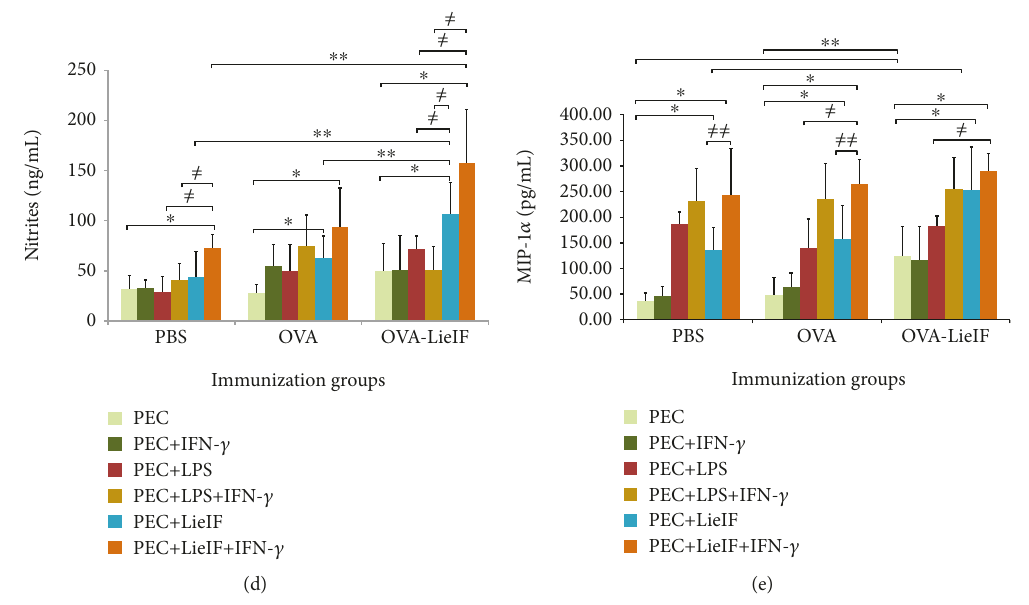
Figure 2: In vivo e ff ect of recombinant LieIF protein on the peritoneal exudate cells. (a) Schematic representation of the experimental protocol. Female BALB/c mice were i.p. injected in the right quadrant with 500 μ L of LieIF suspension (10 μ g/mouse) in sterile PBS containing equal quantity of OVA protein (10 μ g/mouse) or with 500 μ L of OVA suspension (10 μ g/mouse) in sterile PBS, while mice receiving only PBS were included. 2 and 24h after injection, the peritoneal exudate cells (PEC) were harvested with 5mL of ice-cold PBS. (b) Relative expression of TNF- α , IL-1 β , and NF- κ B2 genes in PEC. 2 h post-immunization, PEC were derived from each experimental group and relative expression of TNF- α , IL-1 β , and NF- κ B2 genes was determined by real-time PCR, performed with a SYBR Green PCR Master Mix. The expression of glyceraldehyde-3-phosphate dehydrogenase (GAPDH) gene was used for normalization, and all expression levels were computed via the ΔΔ Ct method. Results shown are representative of three independent experiments. ∗ indicates statistically signi fi cant di ff erences compared to PBS-immunized mice while ∗∗ indicates signi fi cant di ff erences compared to OVA-immunized group. (c) Recombinant LieIF protein induces the upregulated expression of CD80 co-stimulatory molecule in PEC. 24h post-immunization, PEC were harvested from each experimental group and cell surface expression of CD80 and CD86 co-stimulatory molecules was assessed by FACS analysis. The results are expressed as median fl uorescent intensity (MFI) and as percentage (%) of cells expressing CD80